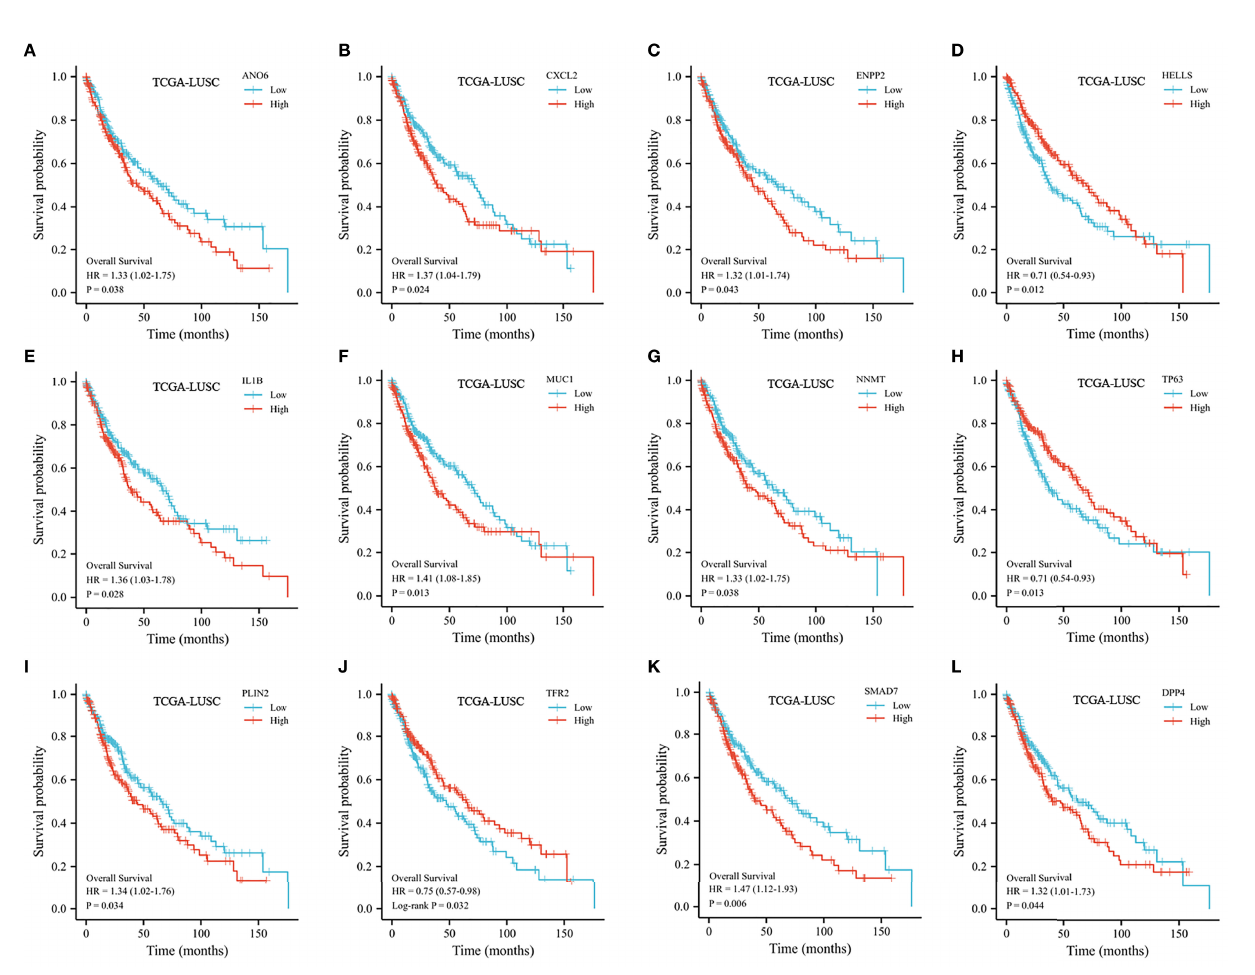
FIGURE 4 | Kaplan – Meier curve of the selected FRGs from the TCGA dataset. (A) Kaplan – Meier curve according to ANO6. (B) Kaplan – Meier curve according to CXCL2. (C) Kaplan – Meier curve according to ENPP2. (D) Kaplan – Meier curve according to HELLS. (E) Kaplan – Meier curve according to IL1B. (F) Kaplan – Meier curve according to MUC1. (G) Kaplan – Meier curve according to NNMT. (H) Kaplan – Meier curve according to TP63. (I) Kaplan – Meier curve according to PLIN2. (J) Kaplan – Meier curve according to TFR2. (K) Kaplan – Meier curve according to SMAD7. (L) Kaplan – Meier curve according to